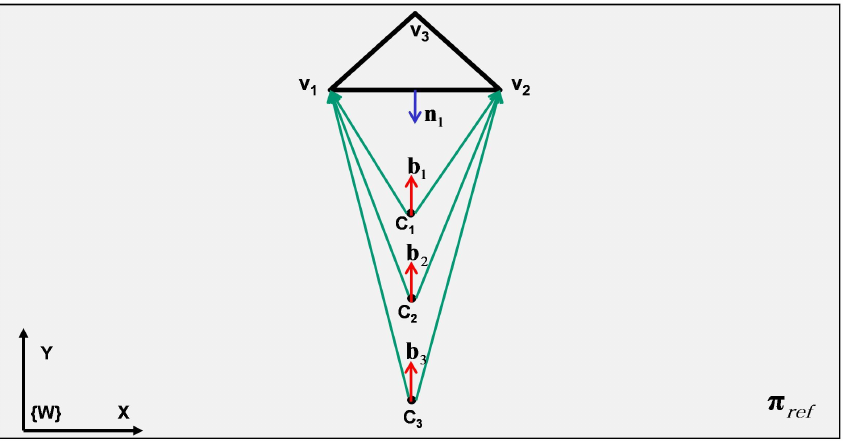
Figure 4. The local minima problem for a triangular polygon and three cameras.